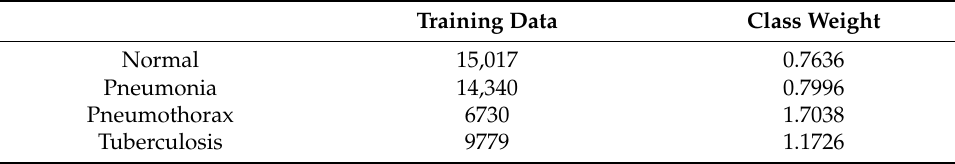
Table 6. SCH data set weights by disease